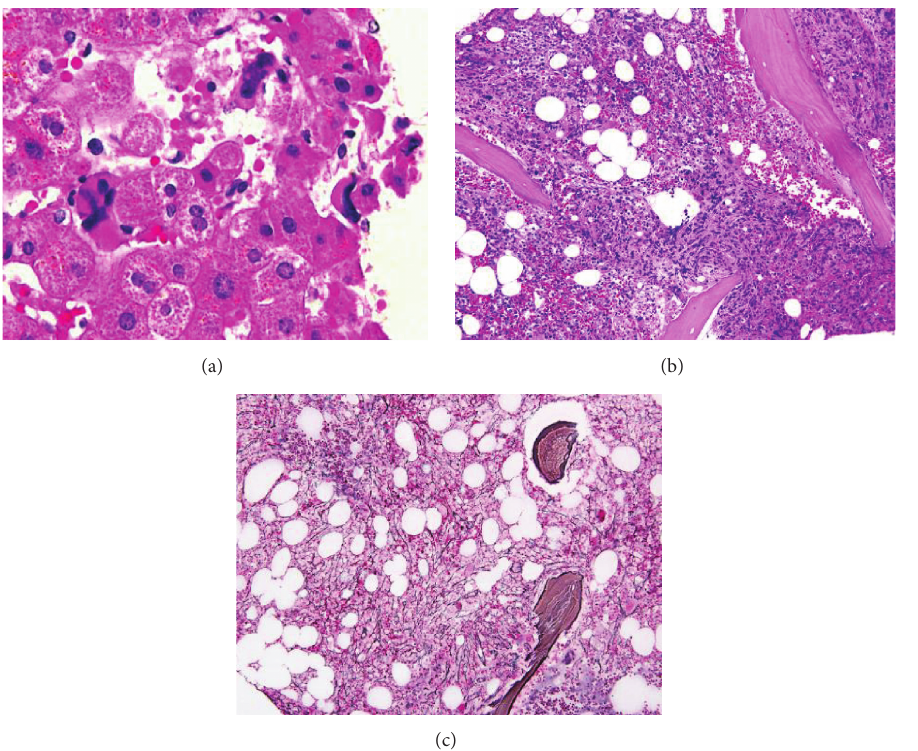
Figure 1: Morphologic findings in liver and bone marrow biopsy. (a) H&E stain of liver, (b) H&E stain of bone marrow biopsy, and (c) reticulin stain of bone marrow biopsy.